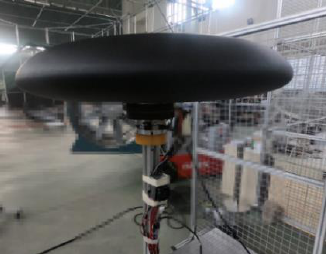
Figure 18. Connection mode of the 400 ducted fan.